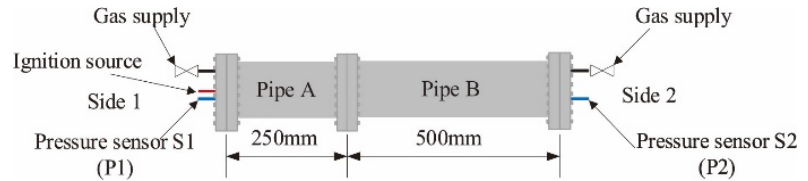
Figure 4. Configuration 1 of sample 1.